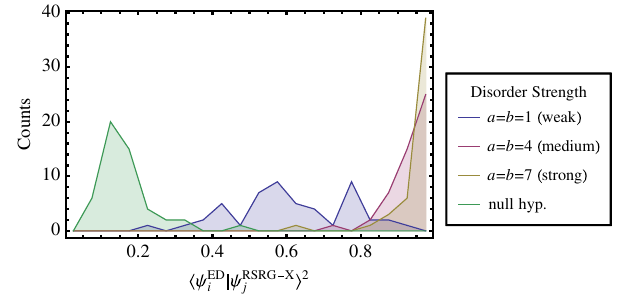
FIG. 7. Histogram of the average overlap of RSRG-X and ED eigenfunctions, computed for three values of disorder strength. Also shown is the histogram for the null hypothesis: average overlap of ED eigenfunctions computed for pairs of different disorder realizations. (See text for